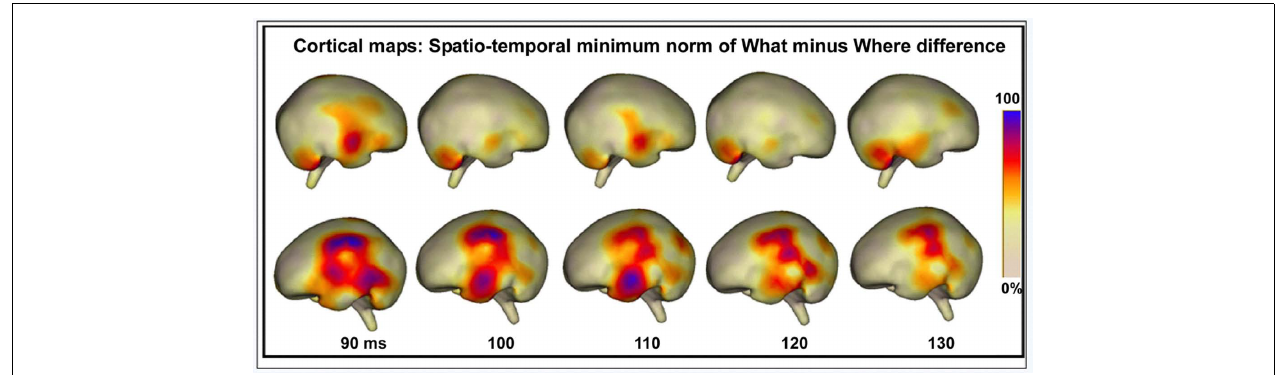
FIGURE 12 | Cortical maps displaying the spatio-temporal minimum-norm topographies for WHAT minus WHERE difference waveforms.